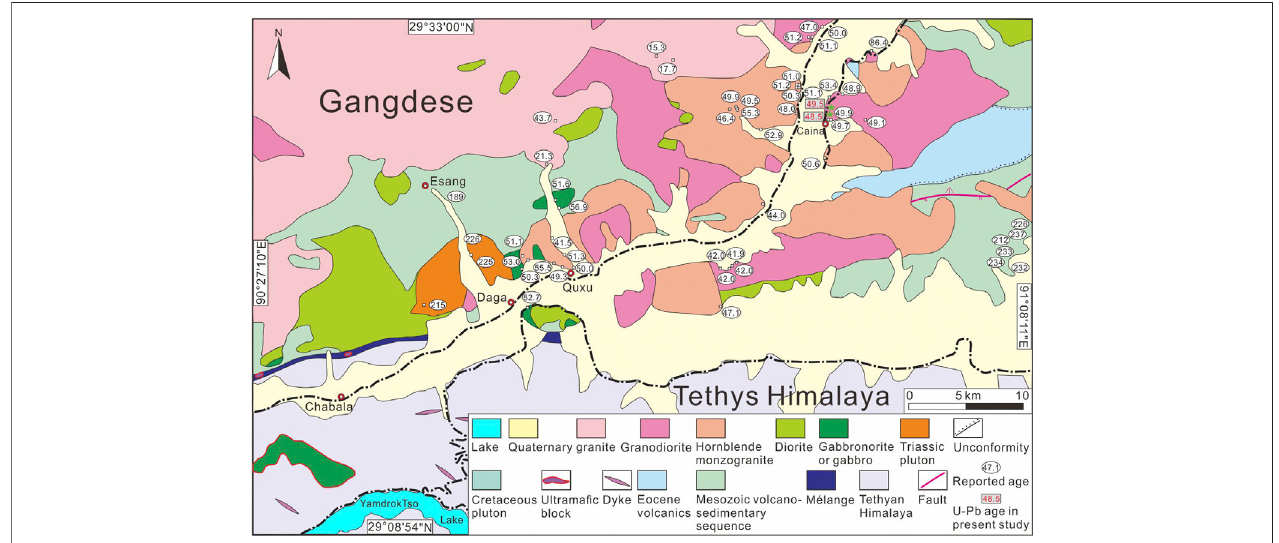
FIGURE 2 | Geological map of the main body of the Quxu batholith in the Gangdese belt. The reported zircon U-Pb data are compiled from Huang et al. (2021), Ji et al. (2009), Ma et al. (2017a, 2017b), Meng et al. (2018b), Mo et al. (2005), Wang et al. (2016), Wang et al. (2019a, 2019b), Wen et al. (2008). These dating results demonstrated that the Quxu batholith was mainly formed between 55 and 45